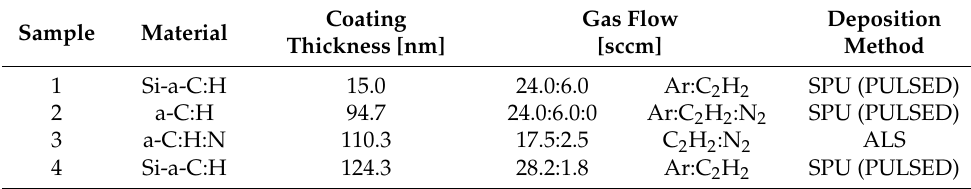
Table 1. Parameters of selected